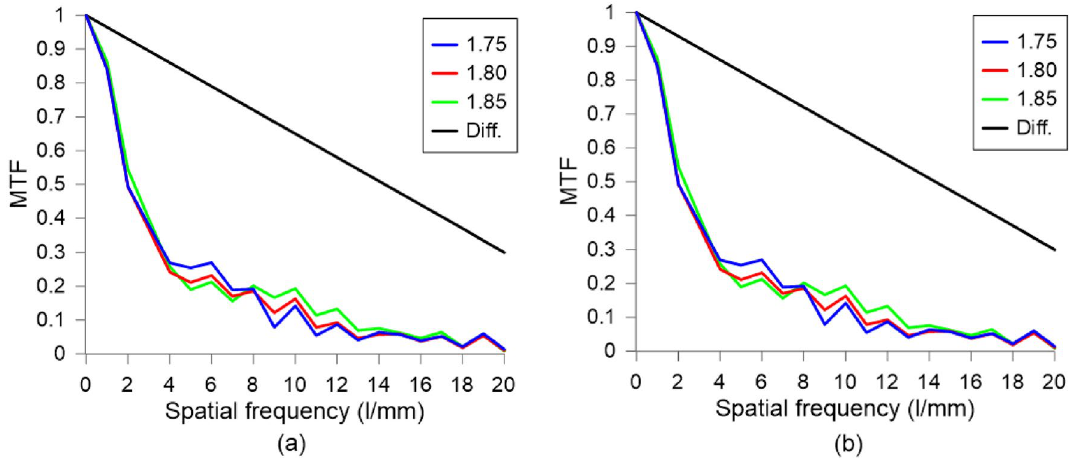
Figure 13. MTFs for ( a ) horizontal and ( b ) diagonal cross-sections for different applied voltages and the diffraction limit